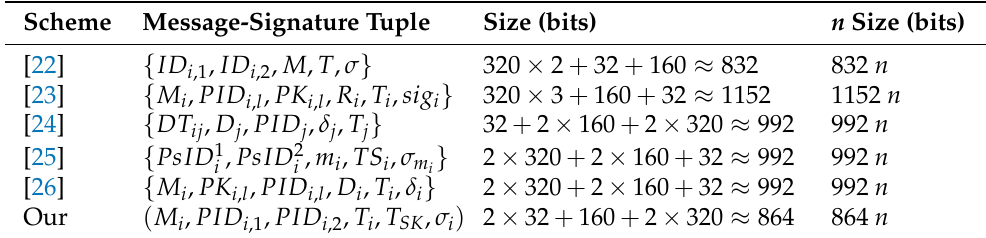
Table 4. Comparison of Communication Costs.